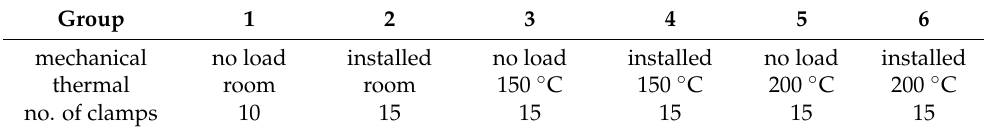
Table 1. Allocation of the number of clamps to the respective loading groups.